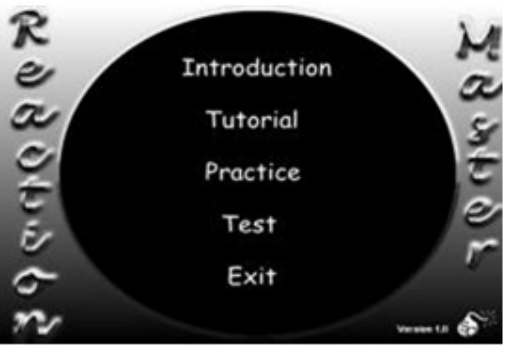
Figure 1. Reacton Master Opening